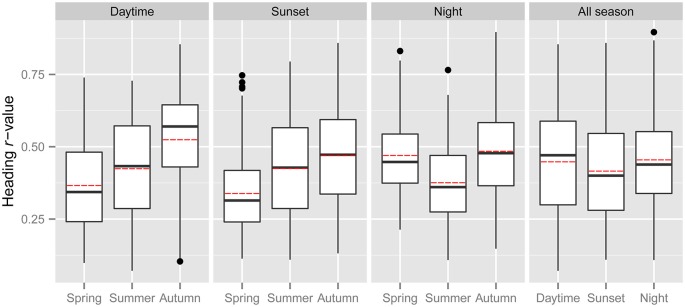
The distribution of heading r-values of “migration events” during the spring, summer and autumn of the three time periods (three panels on the left), and for all seasons combined during the three time periods (panel on the right). The bottom and top of the box show the lower and upper quartile values, respectively. The horizontal solid black line represents the median for each category, and the red dashed line represents the mean. Whiskers indicate the 5th and 95th percentiles, while the black circles show the outliers.